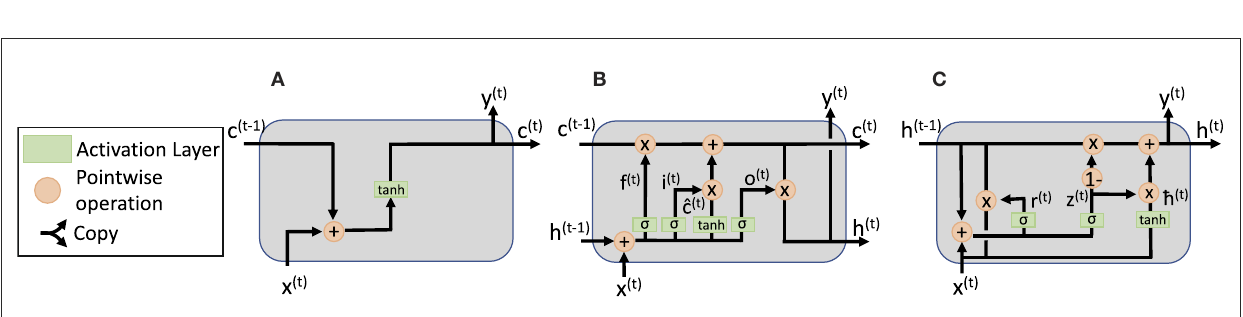
FIGURE4 Schematic representation of non-gated and gated RNN cells: (A) basic RNN cell without any gates that is also representative for the reservoir of an ESN, (B) gated LSTM cell, and (C) gated GRU